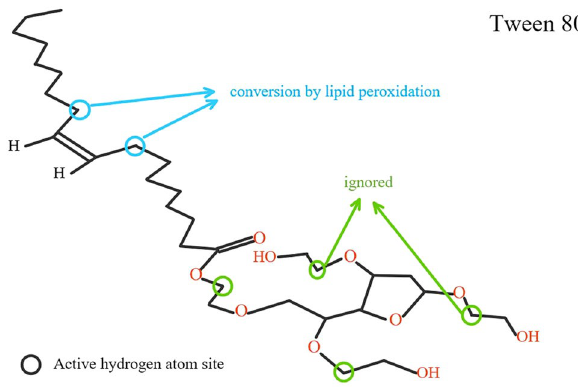
Figure 5. Active hydrogen locus in the tween 80.